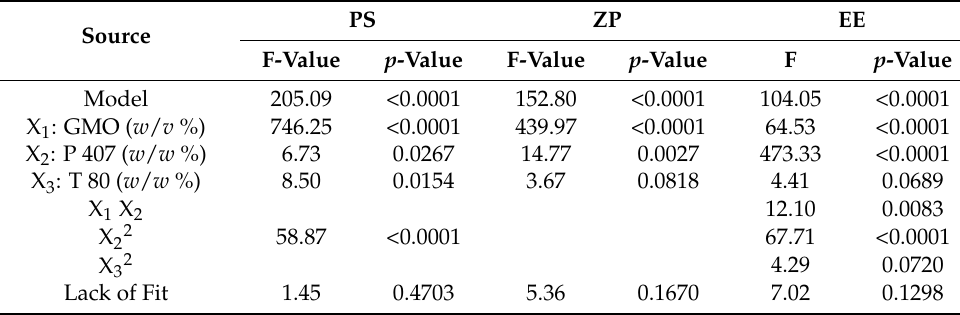
Figure 1. Model diagnostic plots of GS-CBS size (PS), surface charge (ZP), and entrapment effi- ciency (EE). Table 2. The outcomes of all statistical analyses of response